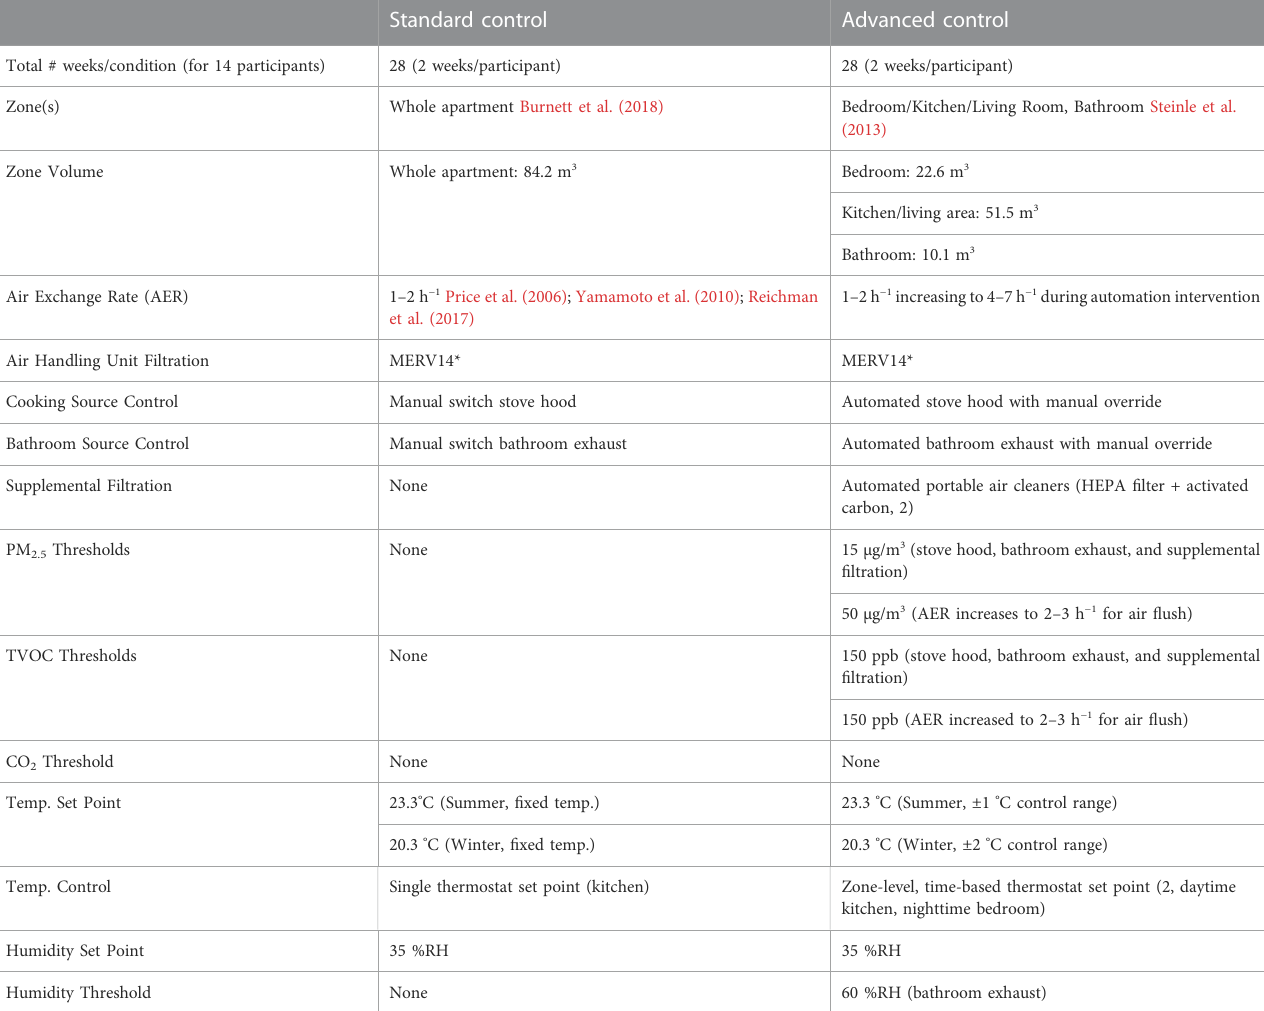
TABLE 1 Experimental design